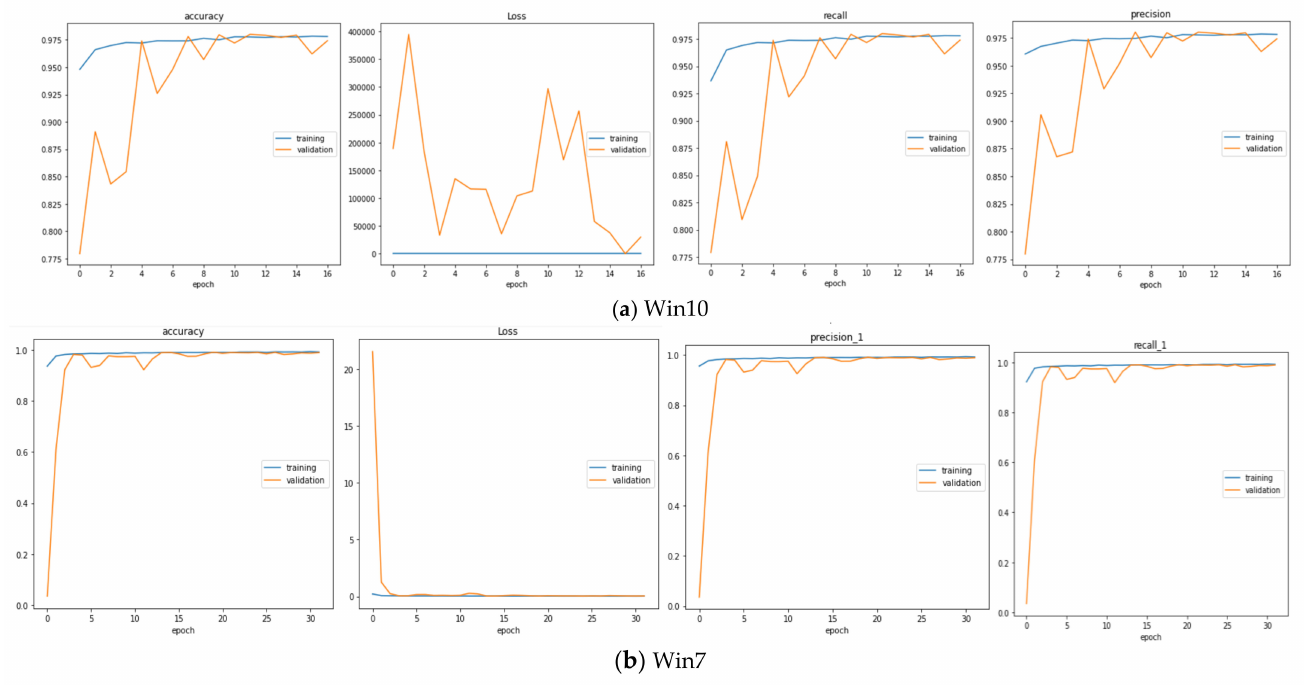
Figure 7. The results (Win7, Win10, Network, Win10–Network) of the Inception Time model of the ToN-IoT dataset.